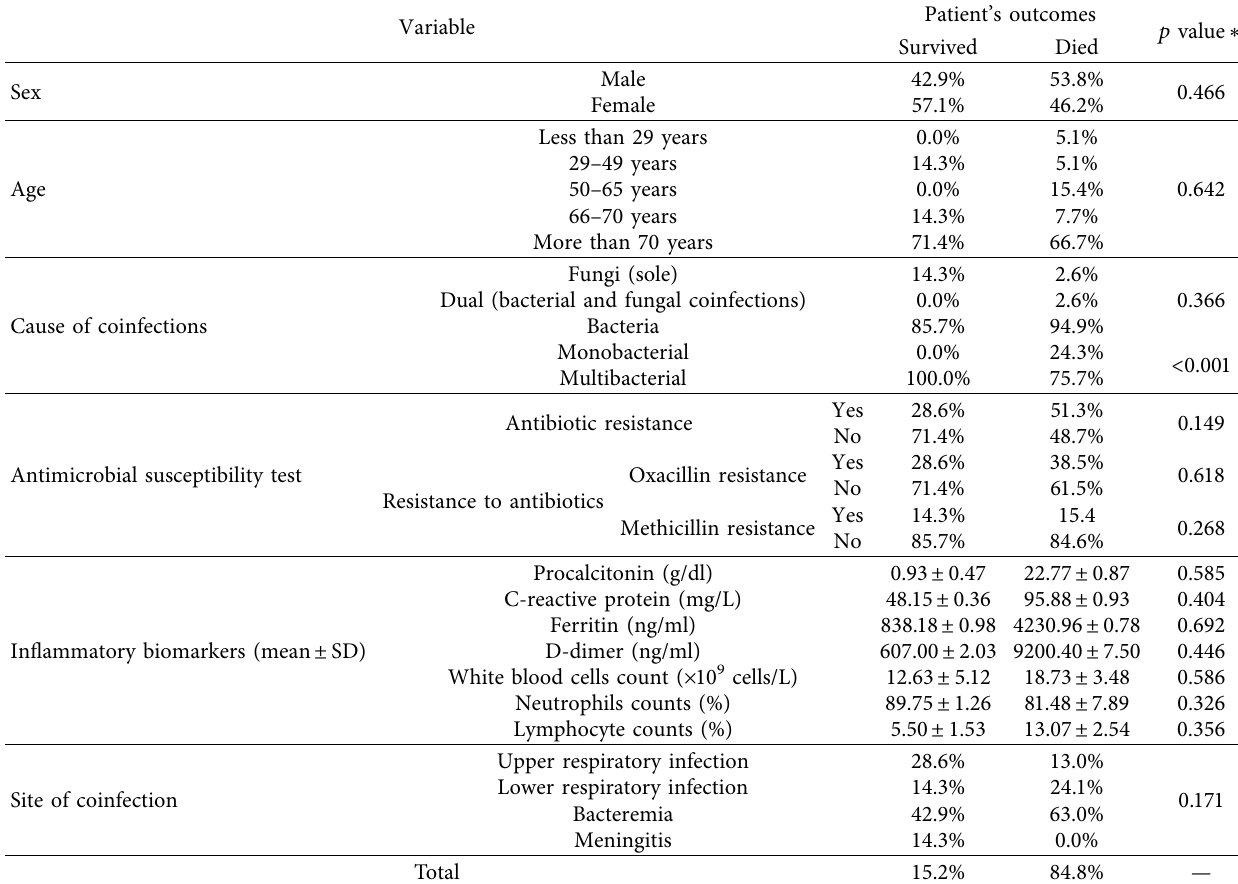
Table 2: Impact of bacterial and/or fungal coinfections among ICU COVID-19